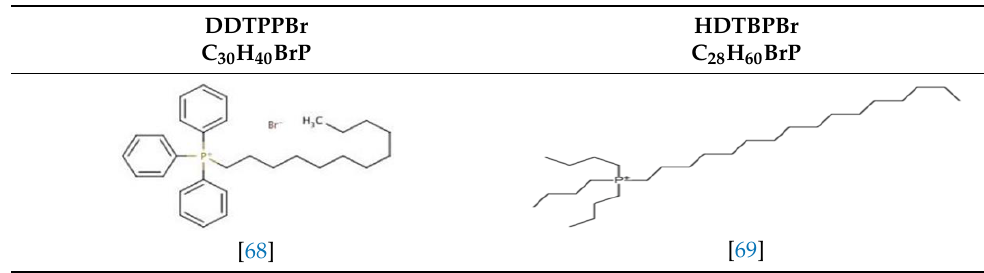
Table 4. Structure of phosphorus heteroatom extractants.